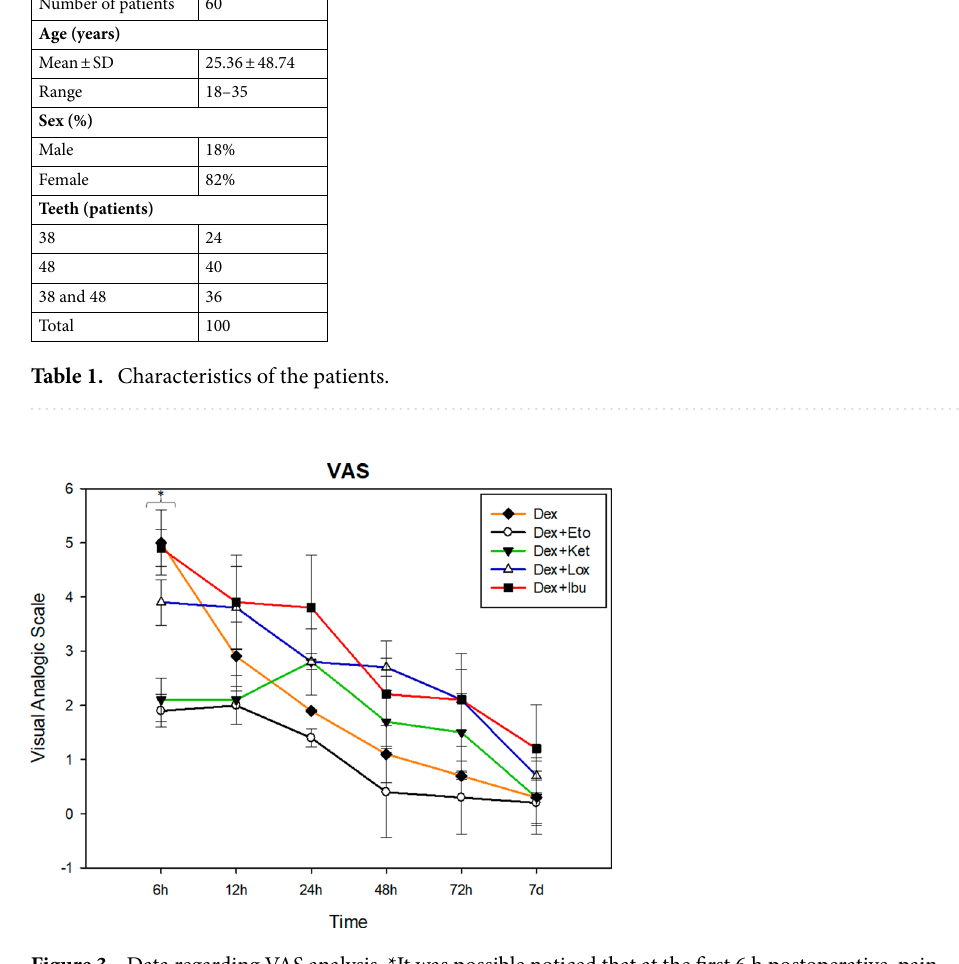
Figure 3. Data regarding VAS analysis. *It was possible noticed that at the first 6 h postoperative, pain perception from DEX + ETO and DEX + KET groups were significantly lower than DEX and DEX + IBU ( P < 0.05—Tukey test). The other postoperative periods showed no significant difference between